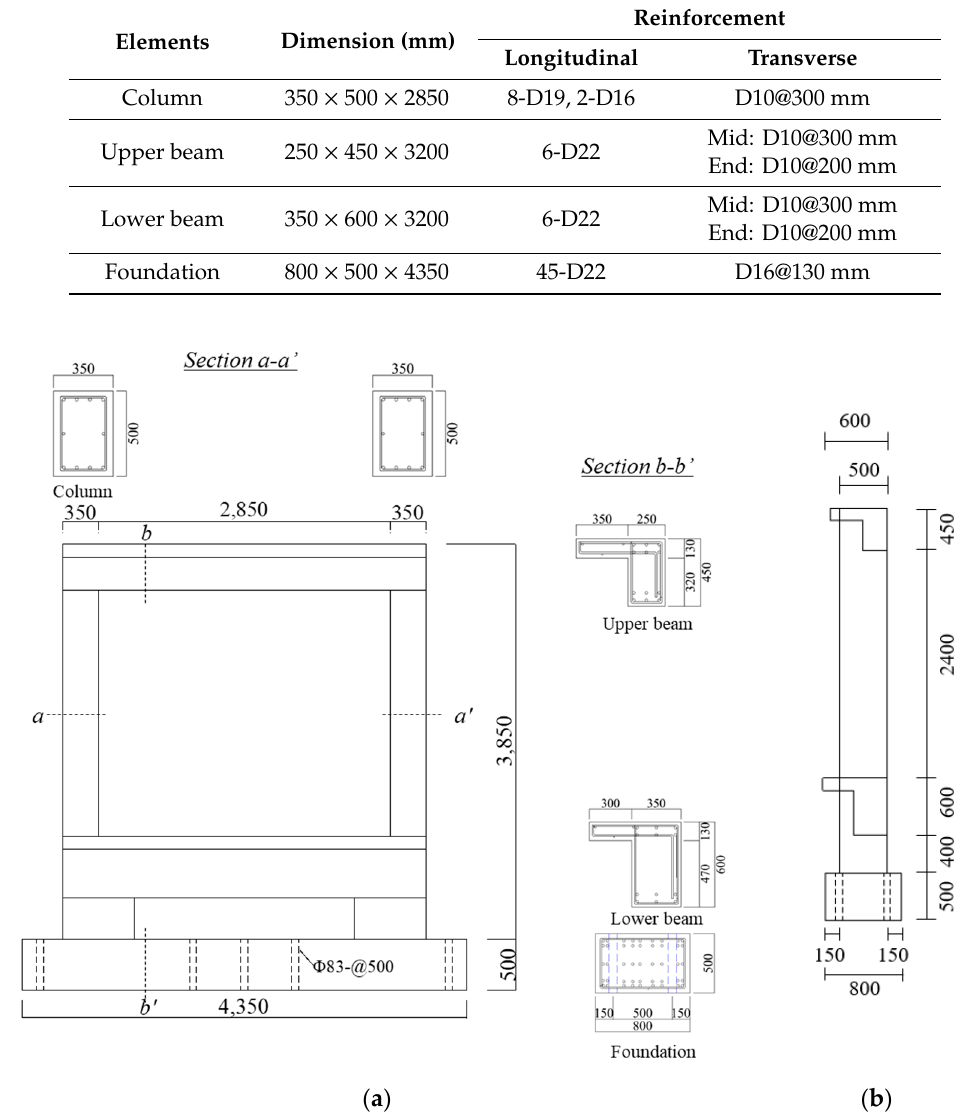
Figure 3. Details of the reinforced concrete frame (mm): ( a ) front view and ( b ) vertical cross-section.